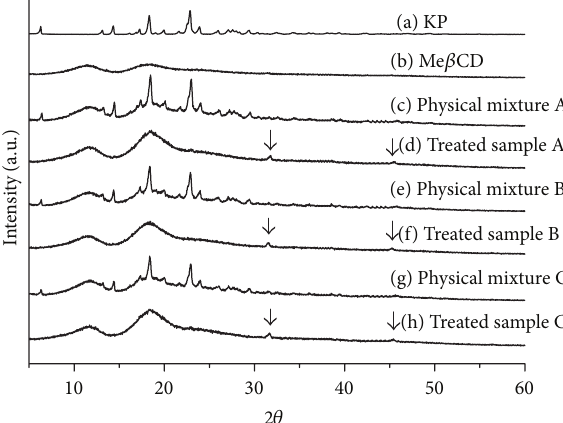
Figure 4: X-ray diffractograms of the pure components, their physical mixtures and the samples treated in scCO 2 : (a) KP, (b) Me 𝛽 CD, (c) physical mixture A (16.3% KP), (d) treated sample A (16.3% KP), (e) physical mixture B (18.7% KP), (f) treated sample B (18.7% KP), (g) physical mixture C (13.8% KP), and (h) treated sample C (13.8% KP). Figure 5: FTIR spectra curves in the C=O stretching region of pure